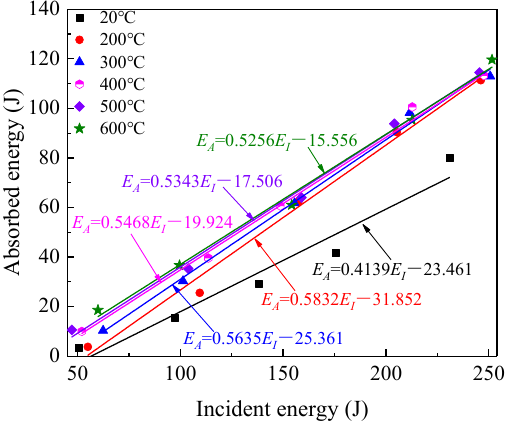
Figure 14. Relationship between absorbed and incident energy.